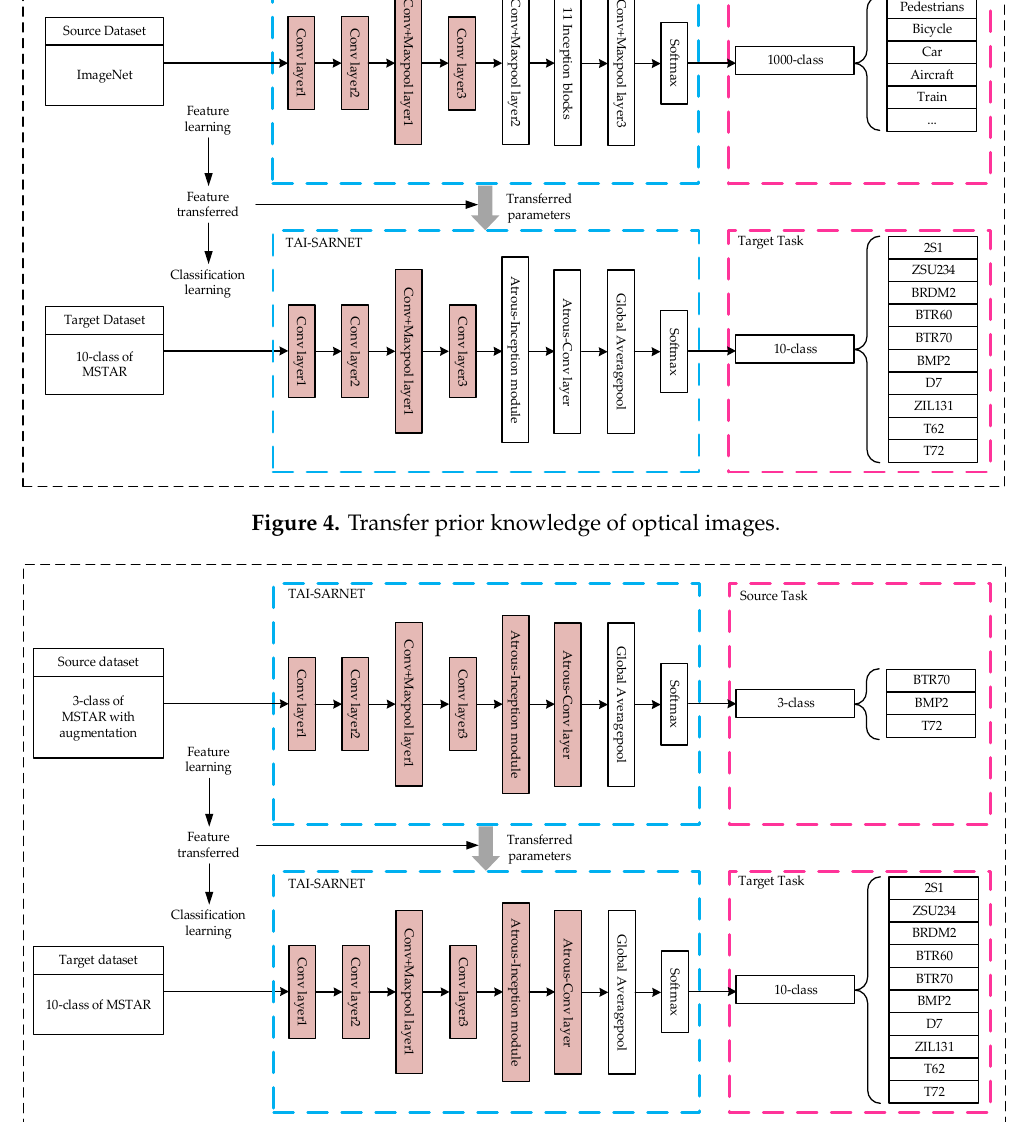
Figure 5. Transfer prior knowledge of non-optical images.